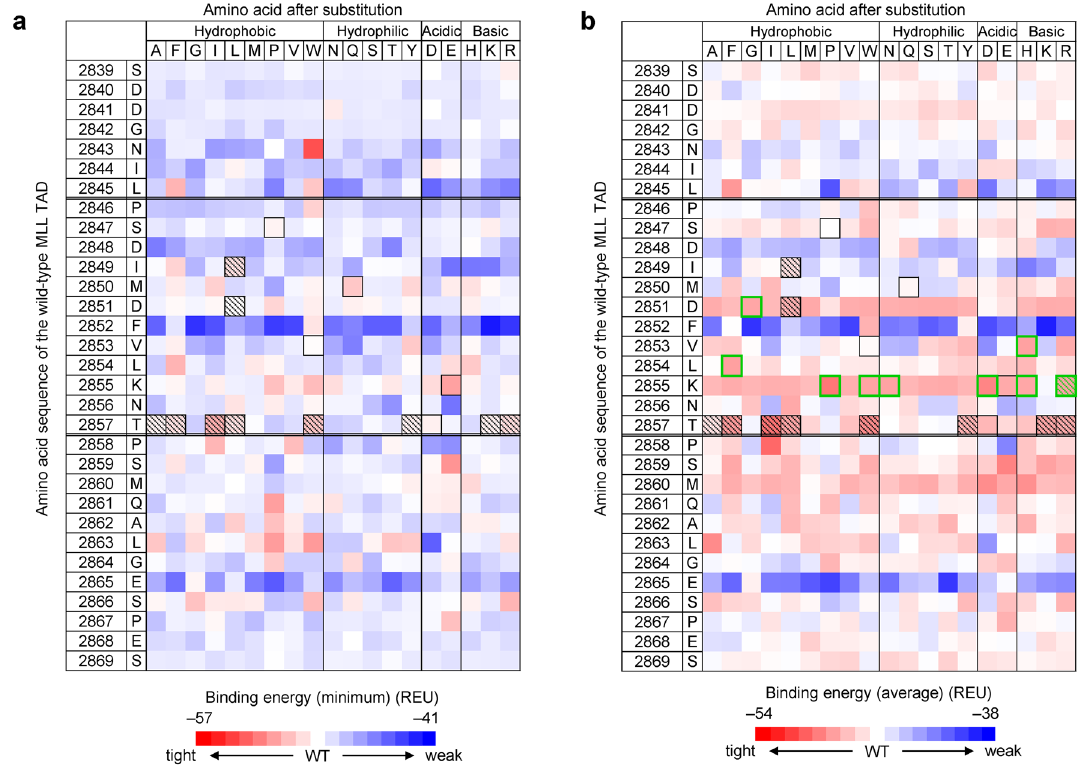
Figure 2. The KIX-binding energies of MLL TAD mutants predicted by saturation mutagenesis using Rosetta. Binding energy (in Rosetta energy unit [REU]) of a mutant represented by a dG_separated value is shown with color gradient from red (tighter binding than the wild type [WT]) to blue (weaker binding than the WT). Left columns show the residue number and the wild-type residue, and top rows show the substituted residue. For each mutant, Rosetta calculation (fixbb) was performed ~ 80 times, and the minimum ( a ) and average ( b ) of the dG_separated values for each mutant are shown. Residues 2846–2857 of the MLL TAD form a helical structure when bound to KIX. Black squares show the mutants selected based on the minimum dG_separated values. In ( b ), green squares show the mutants additionally selected based on the average dG_separated values. The mutants selected for experimental characterization are shown by hatched boxes. The figures were created with Microsoft Excel for Microsoft 365 (Microsoft Corp., Redmond, WA, USA; https:// www. office.